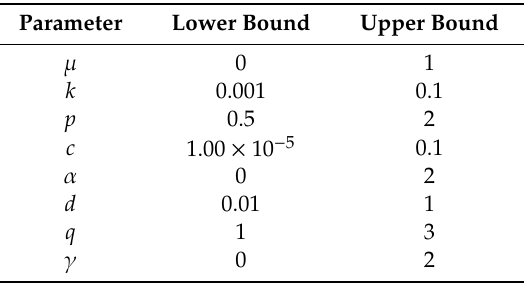
Table 3. Parameter restrictions in our Epidemic Type Aftershock Sequence (ETAS) model. These restrictions are based on the restrictions used for modeling earthquake occurrences and on values that are physically desirables, see